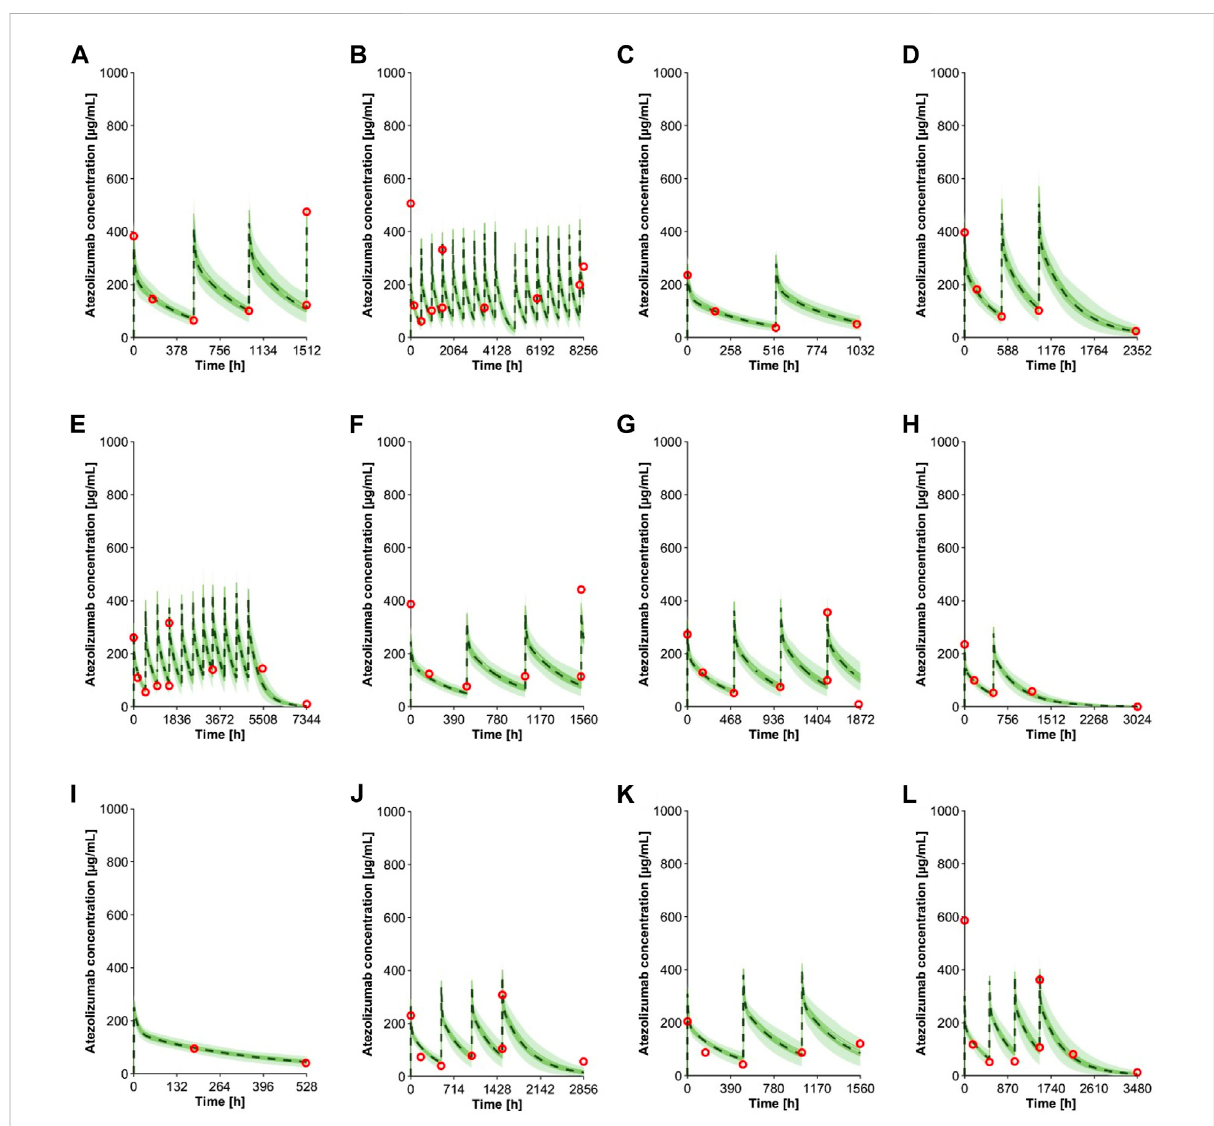
FIGURE 4 Individual observed plasma concentrations (Shemesh et al., 2019) and simulations of multiple IV doses of 15 mg/kg ( < 18 yo) or 1,200 mg ( ≥ 18 yo) atezolizumab Q3W in pediatrics. The panels show data from subjects with different age (A) 16 yo, (B) 15 yo, (C) 13 yo, (D) 12 yo, (E) 11 yo, (F) 10 yo, (G) 8 yo, (H) 7 yo, (I) 5 yo, (J) 4 yo, (K) 3 yo, and (L) 2 yo. Observed data (Shemesh et al., 2019) are shown in red open circles. The green lines represent simulated trials, and the dashed black lines represent the mean data for the entire simulated population ( n = 100). The green shaded area represents the 5th to 95th percentiles of the